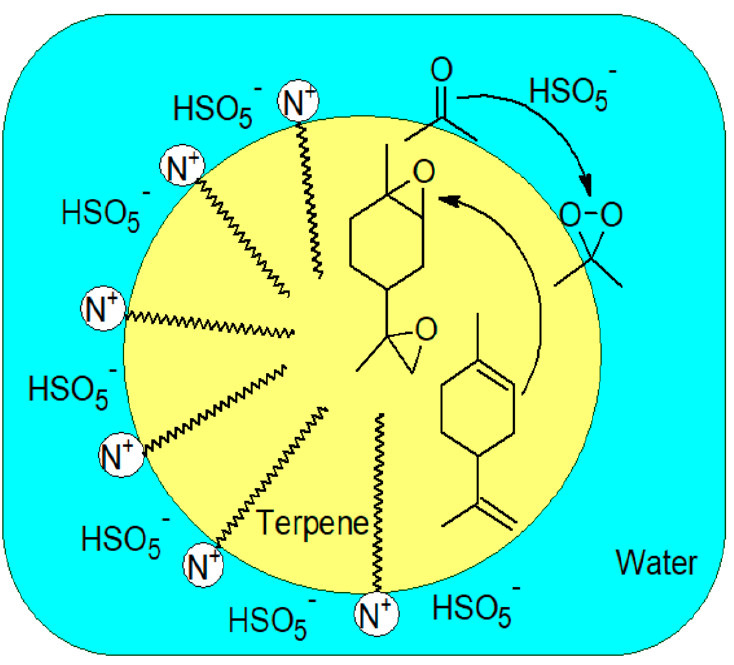
Figure 2. Dispersion of reagents and epoxidation reaction within the micelle. Table 2. Epoxidation of limonene in presence and absence of CTAHS [48].